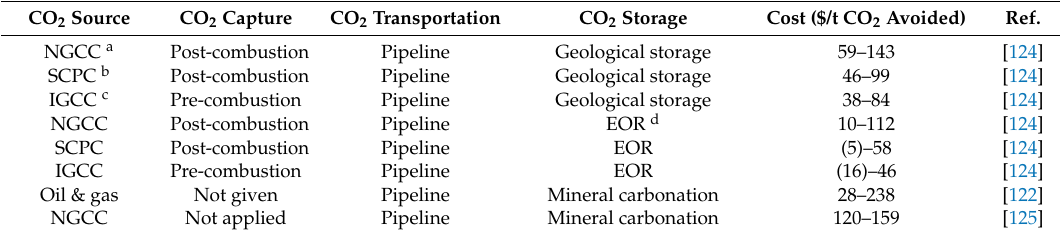
Table 3. The cost of selected CCS